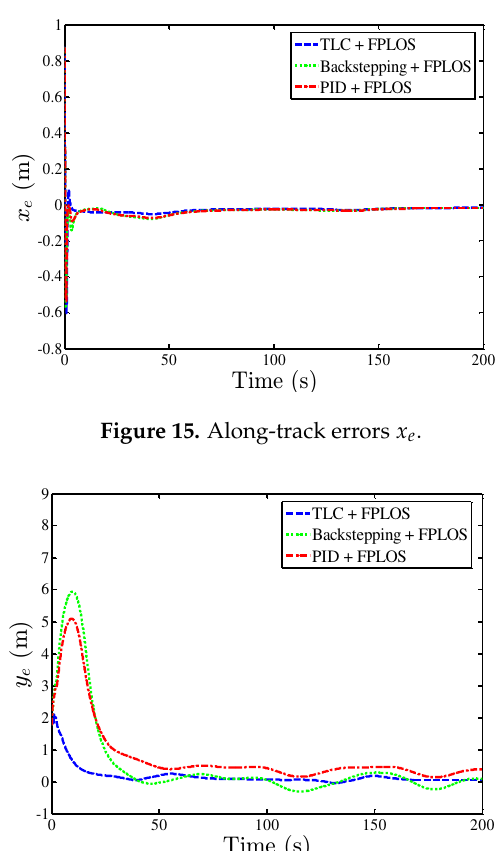
Figure 14. Sideslip angle estimation errors ˜ β .